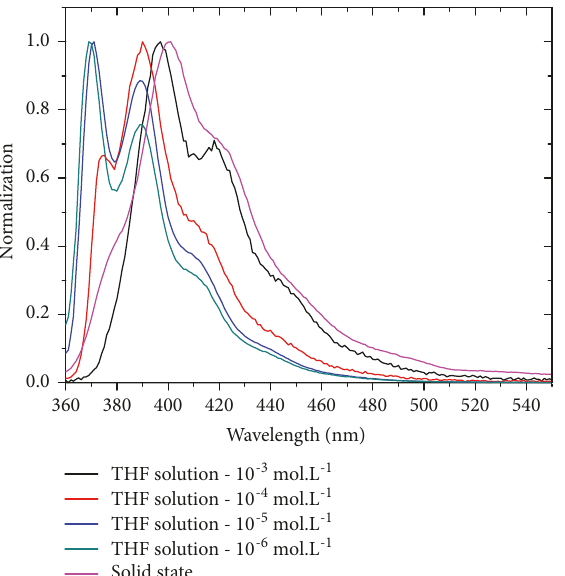
Figure 8: Spectra of the light-emitting of the polymer LaPPS71 in different concentrations of solution and solid state ( 𝜆